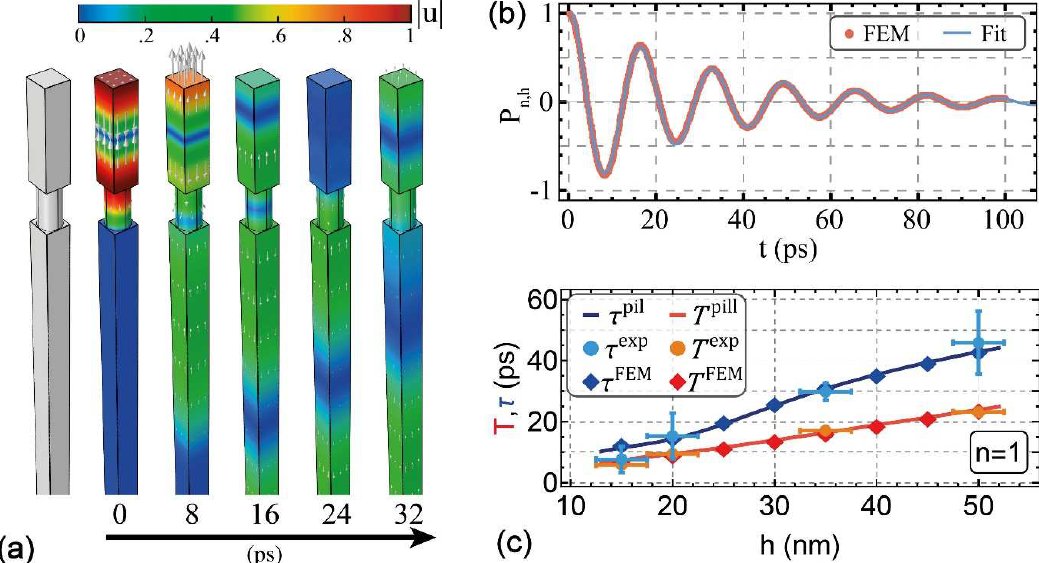
Figure 10. Pillar model FEM and analytical simulation results. ( a ) Simulation domain and displacement field (arrows) and modulus (color map) at increasing times for n = 1, h = 40 nm, and q = 12 nm. ( b ) Normalized projection coefficient P n =1, h =40 (i.e., the autocorrelation of the displacement field for the second eigenmode in a film with a thickness of 40 nm) vs. time for the case represented in panel ( a ) (full red dots); its fit with a damped oscillation of period T and decay time τ (blue line). ( c ) Periods and decay times vs. film thickness: FEM simulations (diamonds) and analytical 1D pillar model (solid lines) adapted from ref. [93] and experimental data (dots), adapted from ref. [37]; further permission related to the material excerpted should be directed to the ACS.